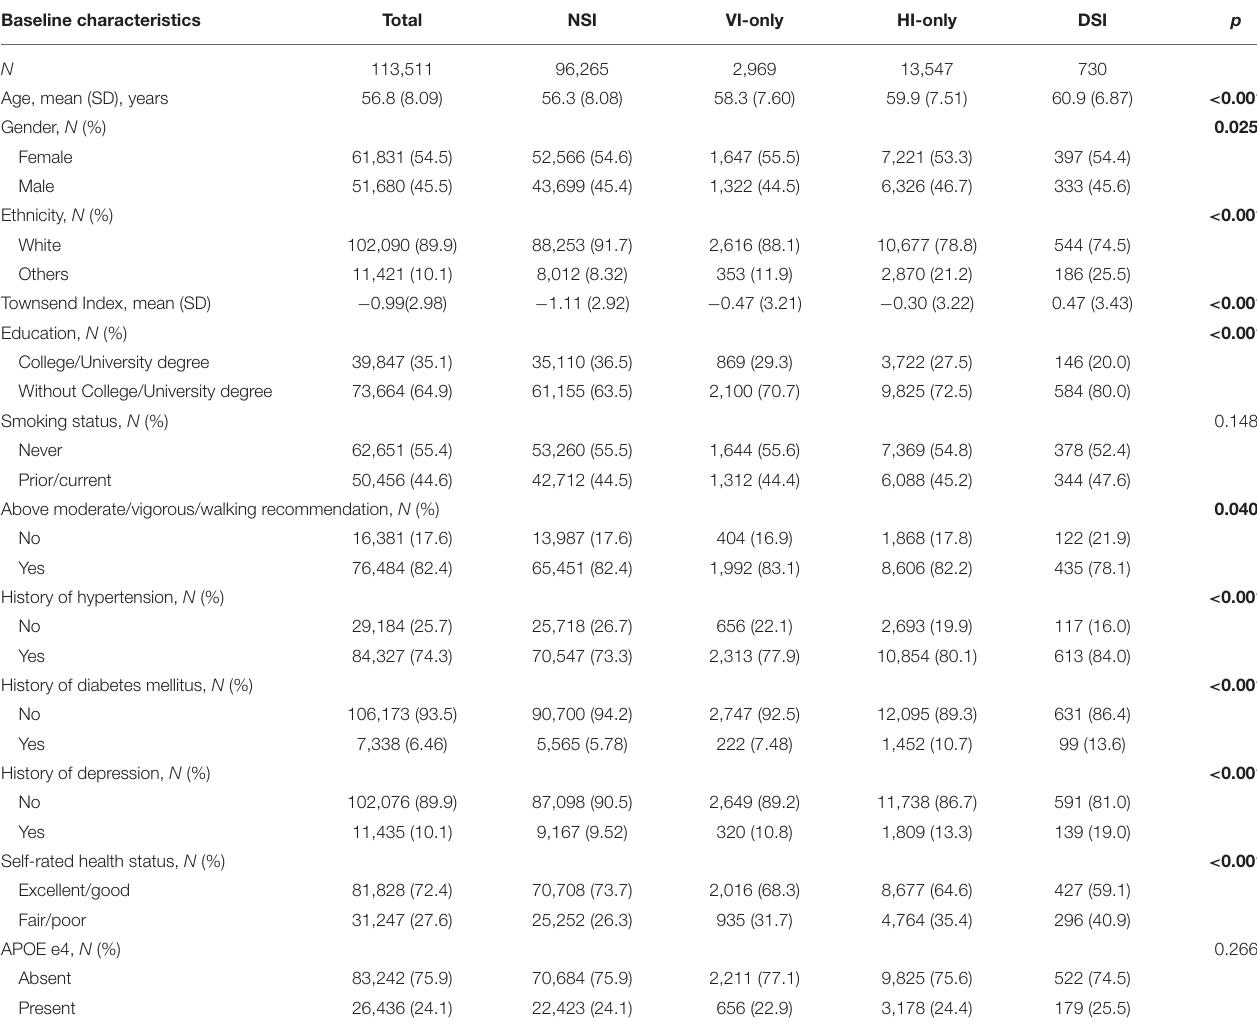
TABLE 1 | Baseline characteristics of participants stratified by the status of sensory impairment. Baseline